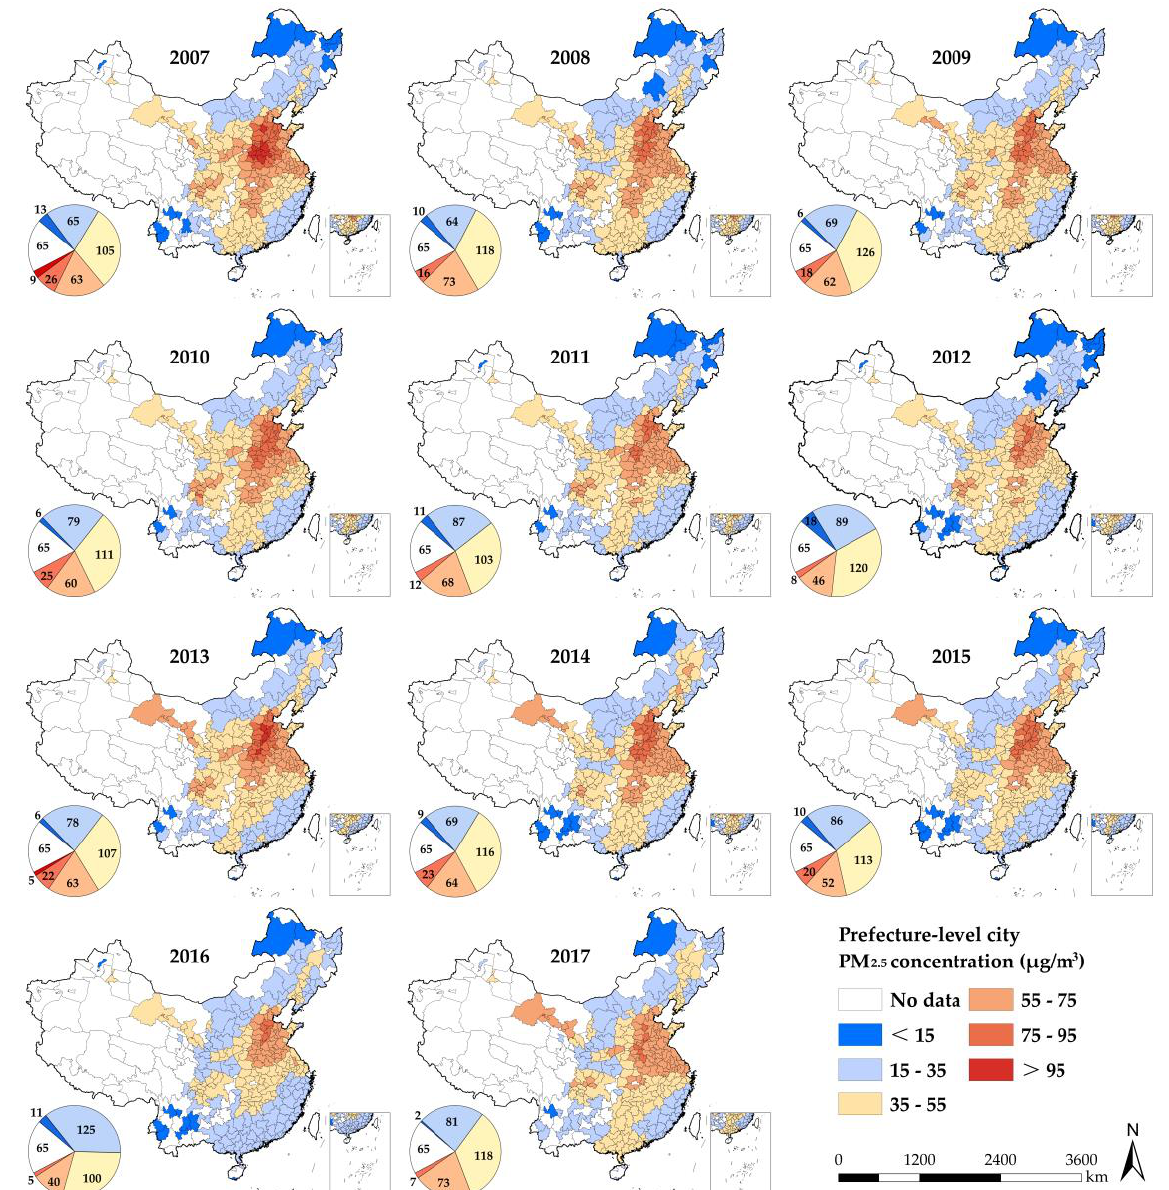
Figure 3. Geographical distribution of China’s PM 2 . 5 pollution.